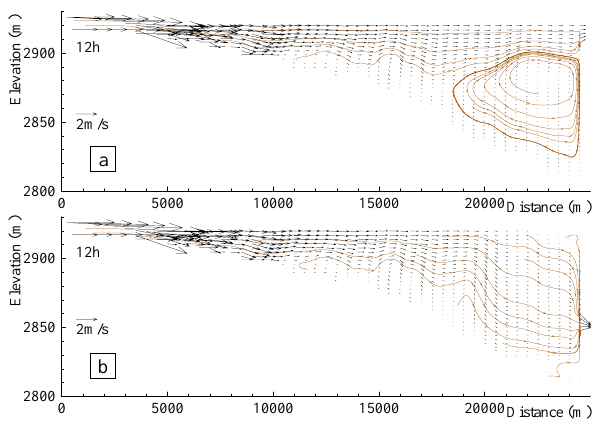
Fig. 7. Water temperature stratification in Bala Reservoir ( ◦ )